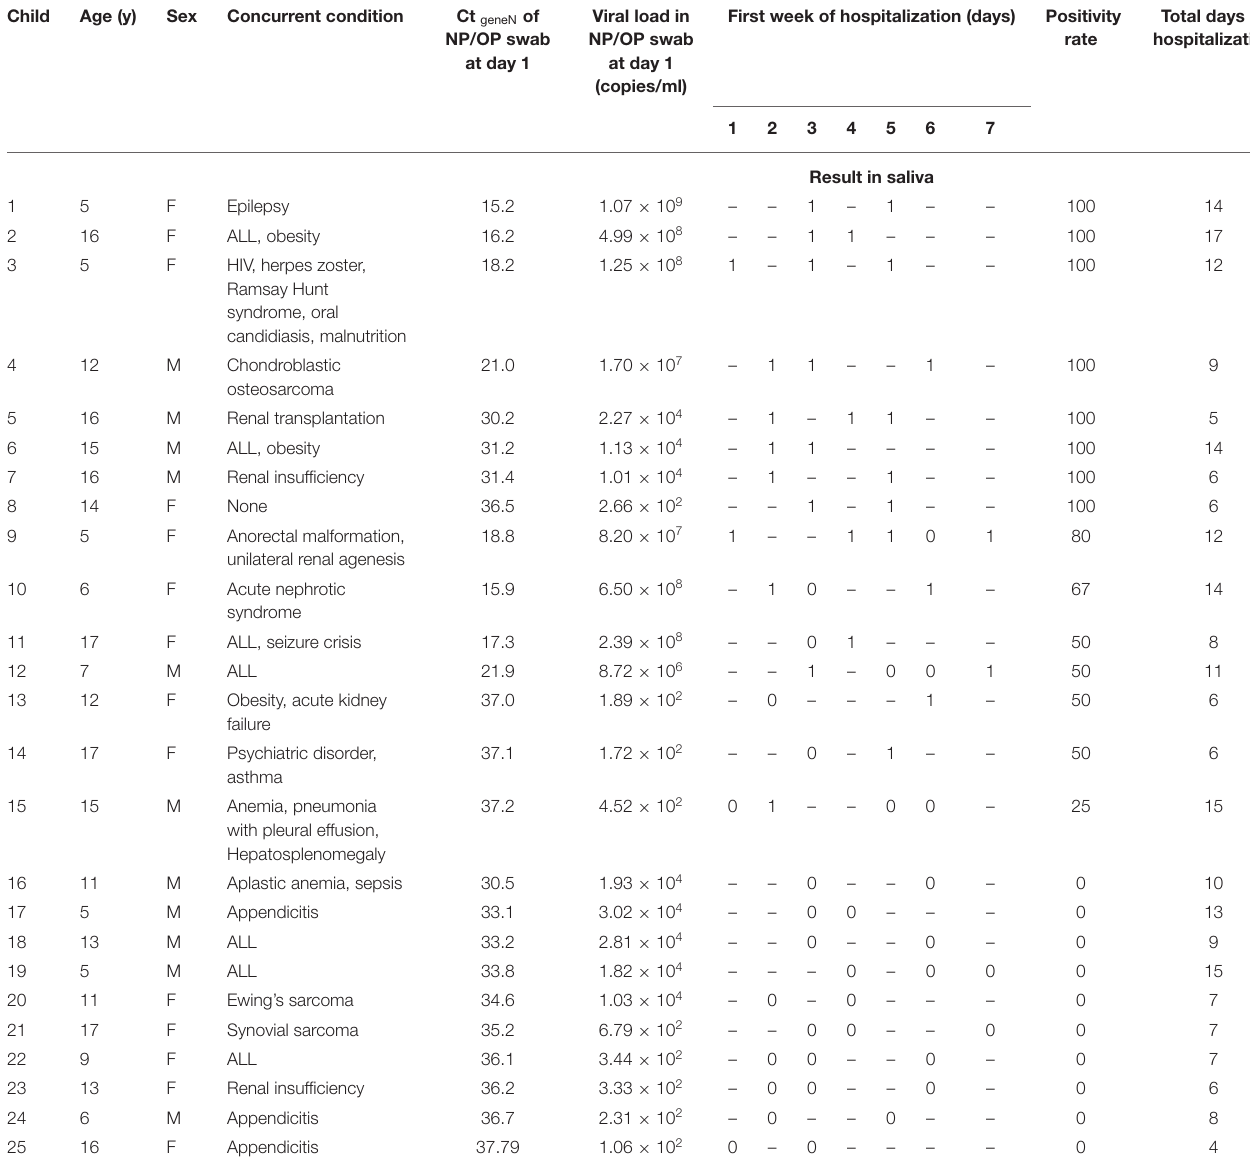
TABLE 3 | Positivity rates in saliva of children and adolescents with confirmed COVID-19 during their first week of hospitalization. Child Age (y)